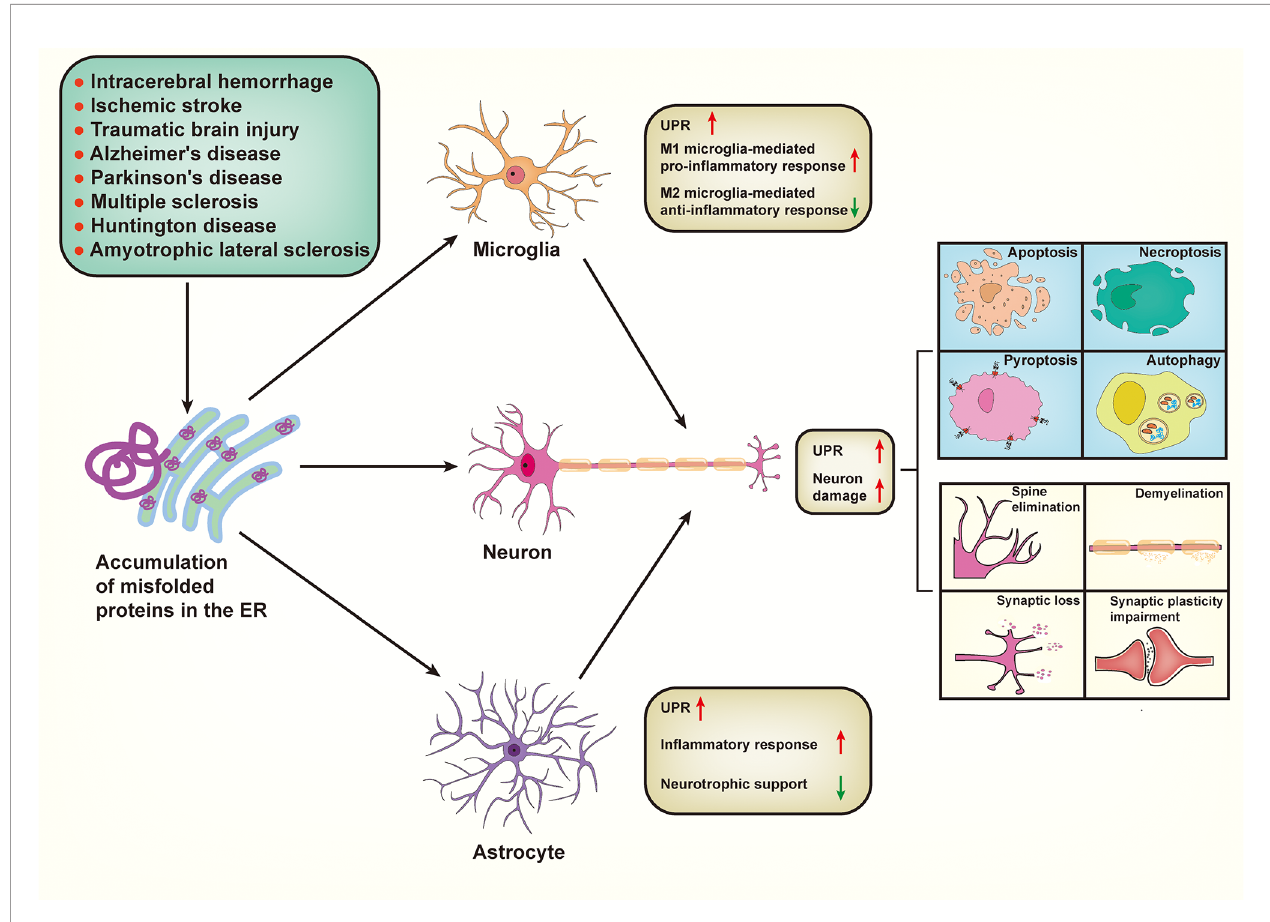
FIGURE 3 | Proposed mechanism by which endoplasmic reticulum stress signaling impacts the overall central nervous system envirment. Various neurological diseases share a common pathogenesis, that is aberrant accumulation of misfolded proteins within the endoplasmic reticulum (ER). Pathologically, accumulation of misfolded proteins in ER subsequently triggers ER stress and concomitant unfolded protein response (UPR) in microglia, astrocytes, and neurons in various neurological diseases. ER stress occurred in neurons can trigger UPR, resulting in a series of neuronal damage including cell death (apoptosis, necroptosis, pyroptosis, and autophagy), spine elimination, demyelination, synaptic loss, and synaptic plasticity impairment. In addition, UPR-activated microglia promote the polarization of microglia from pro-in fl ammatory M1 phenotype to anti-in fl ammatory M2 phenotype. Similarly, UPR-activated astrocytes exhibit an increase of in fl ammatory response but a decrease of neurotrophic support. Importantly, both microglia-mediated and astrocyte-mediated in fl ammatory responses can “ transmit ” ER stress to neurons, thereby aggravating neuronal